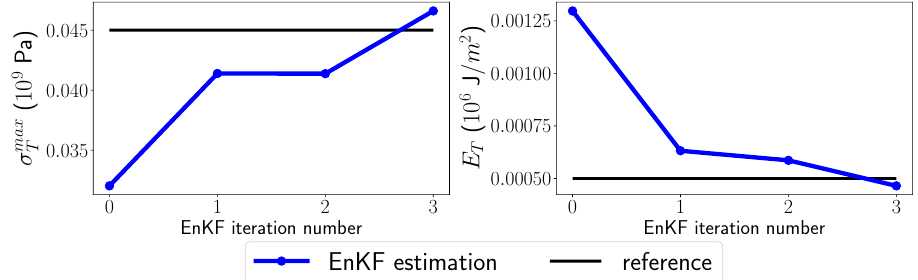
Figure 4. Ensemble average parameter value (blue line) for the initial sample, generated from LHS using Table 2, and three EnKF assimilation iterations, as well as the reference parameter value (black line) also taken from Table 2. As can be seen, with each iteration, the EnKF provides an estimated parameter value (blue line) that is closer to the reference parameter value (black line). From these experiments, three iterations of the EnKF seem to be sufficient to estimate the correct value for both and E t . parameters σ max t